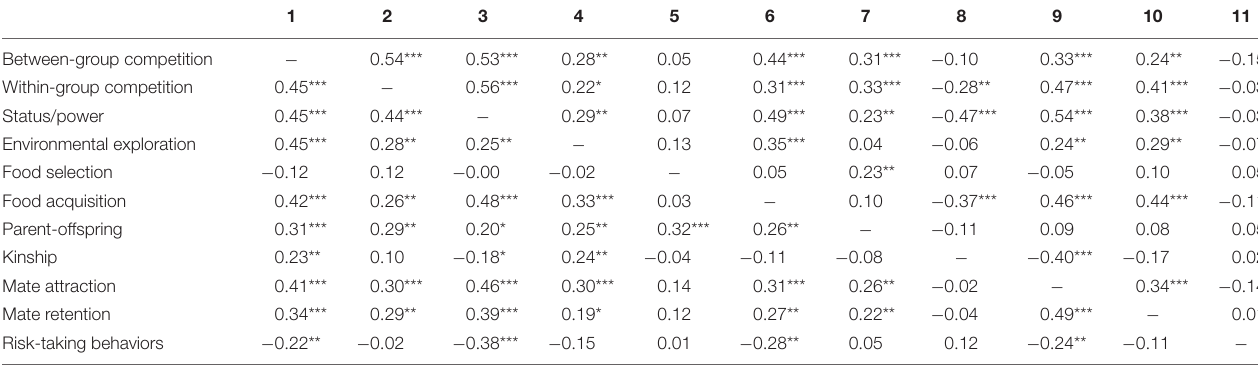
TABLE 4 | Zero-order correlations between risk perception in the evolutionary-specific domains and risk-taking behaviors by sex.